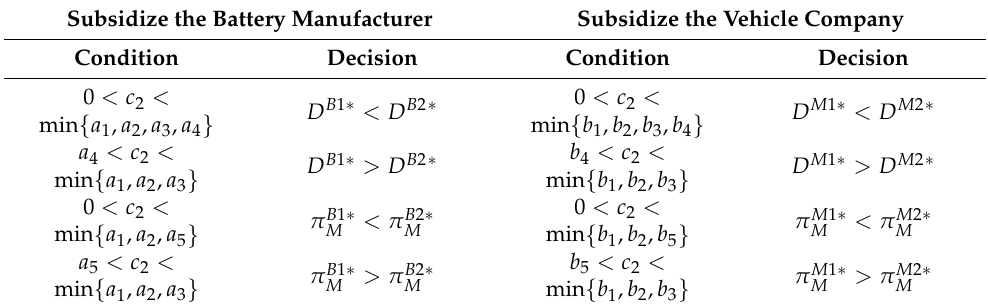
Table 4. Comparison of the vehicle company’s processing strategies under the fixed subsidy